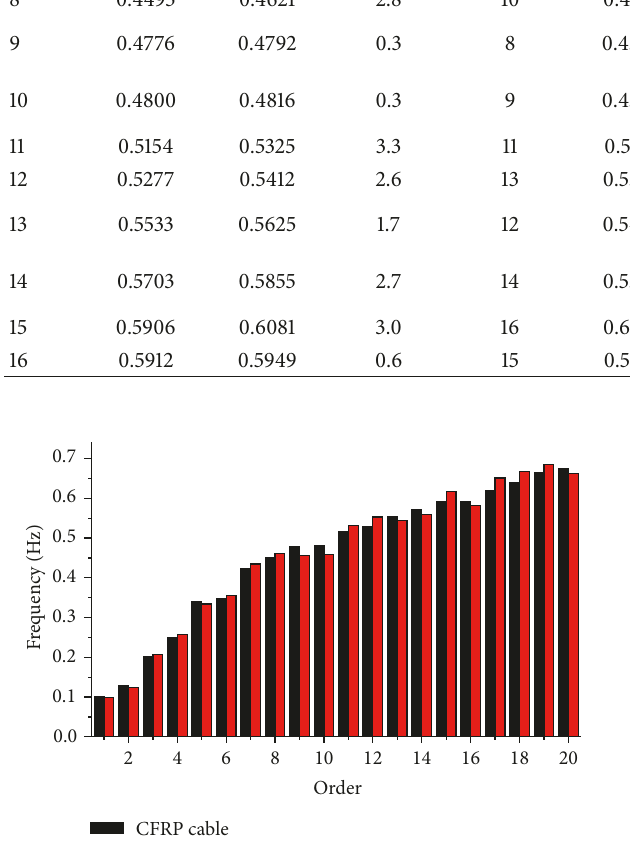
vertical bending natural vibration frequency of CFRP cable- stayed bridge will be higher than steel cable-stayed